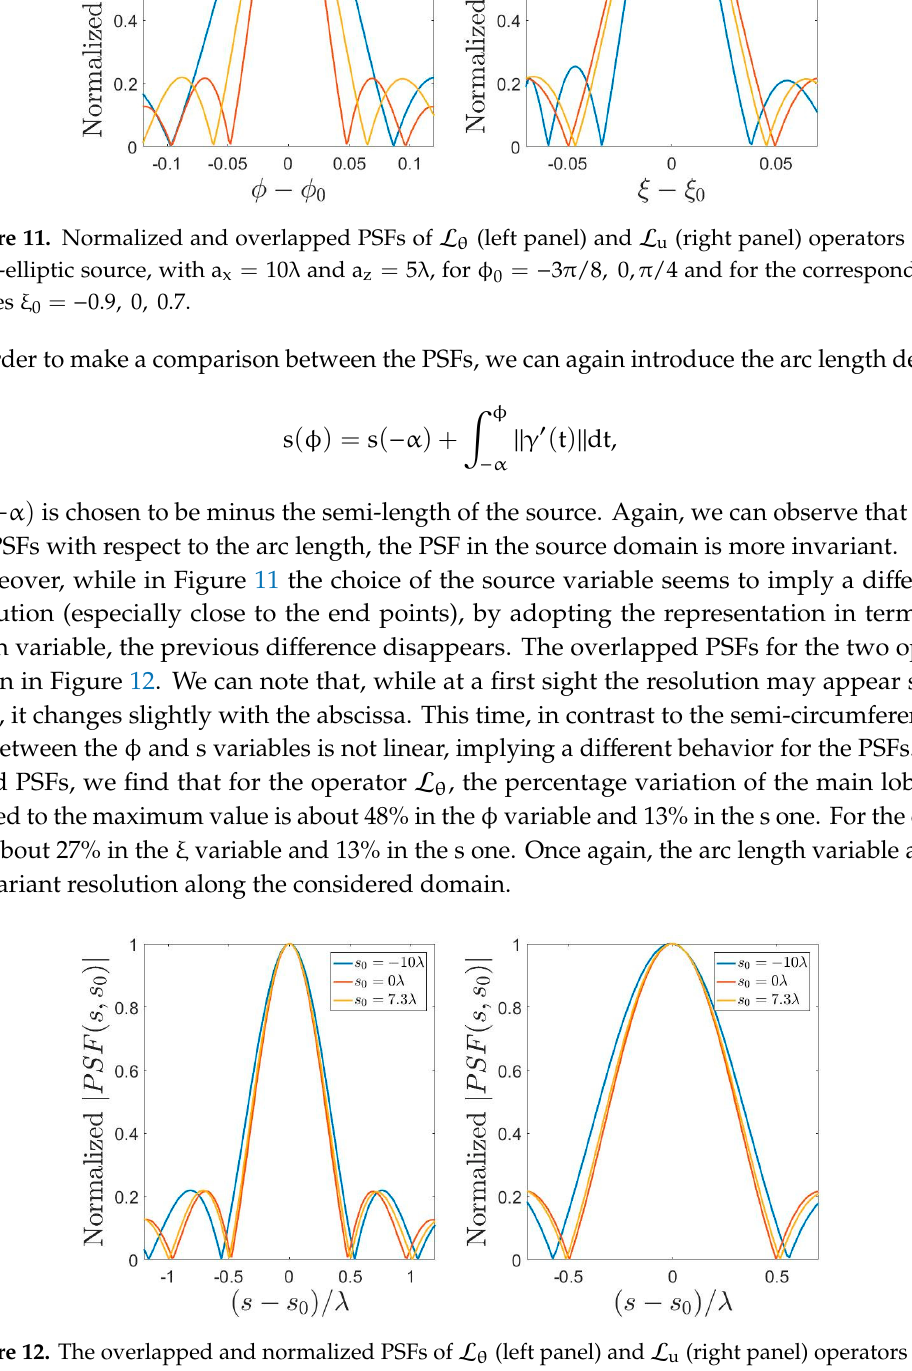
Figure 12. The overlapped and normalized PSFs of L θ (left panel) and L u (right panel) operators of a semi-elliptic source with a x = 10 λ and a z = 5 λ , plotted in function of the arc length variable (the s 0 values are computed in correspondence to the φ 0 and ξ 0 used in Figure 11).